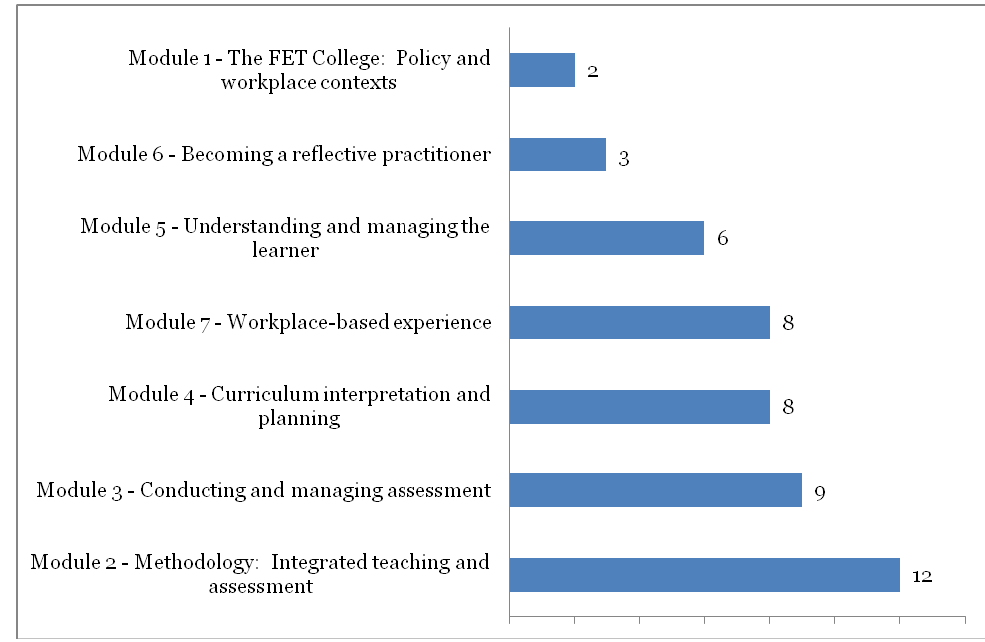
Figure 1 . Modules rated as the best by the participants.